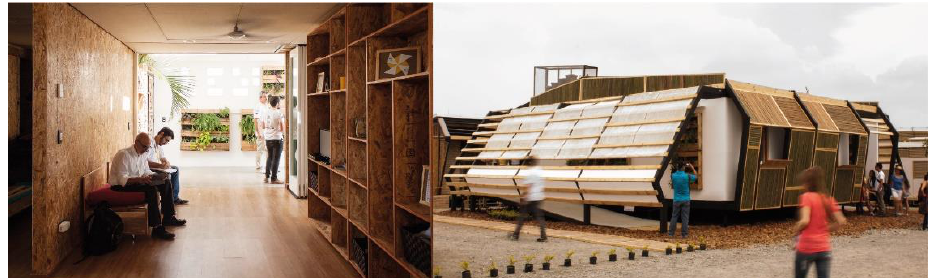
Figure 1. Photograph of the entrance hall seen from inside and South façade/Aura 1.0 prototype.